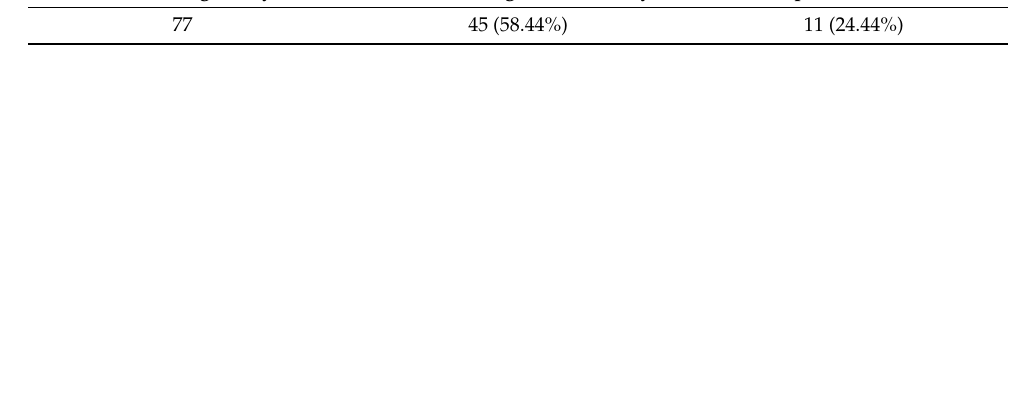
Table 1. The derivation rates of paAFSCs from ICR parthenogenetic diploid blastocysts. No. of MII-Stage